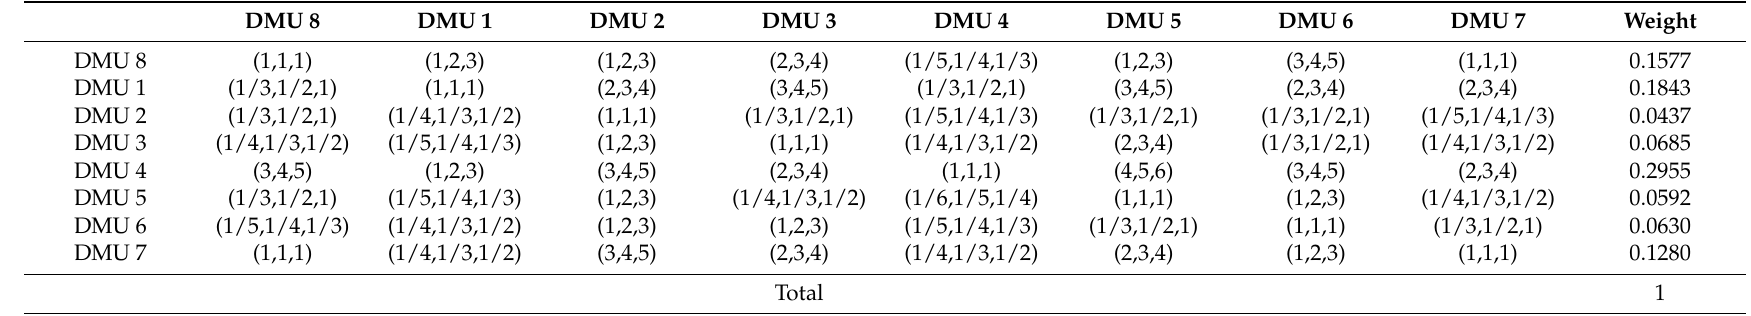
Table A28. Comparison matrix for IEE based on alternatives.